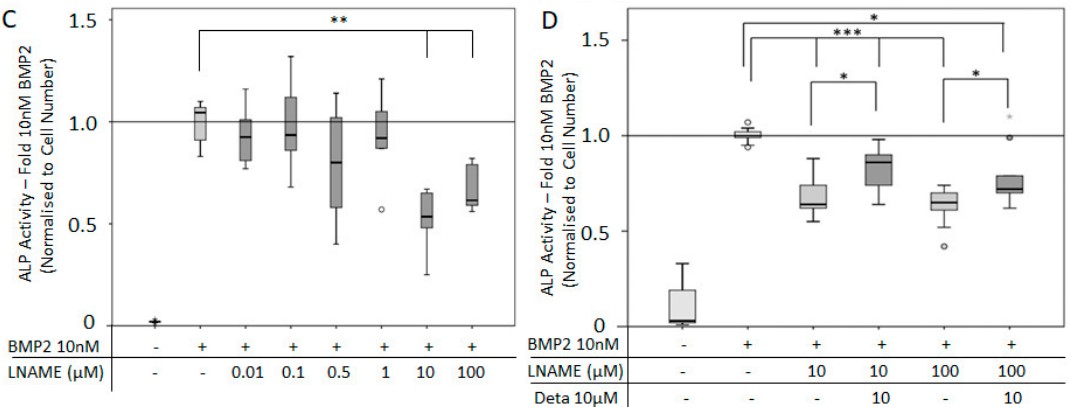
Figure 2. BMP reporter and alkaline phosphatase activity (ALP) activity following the inhibition of